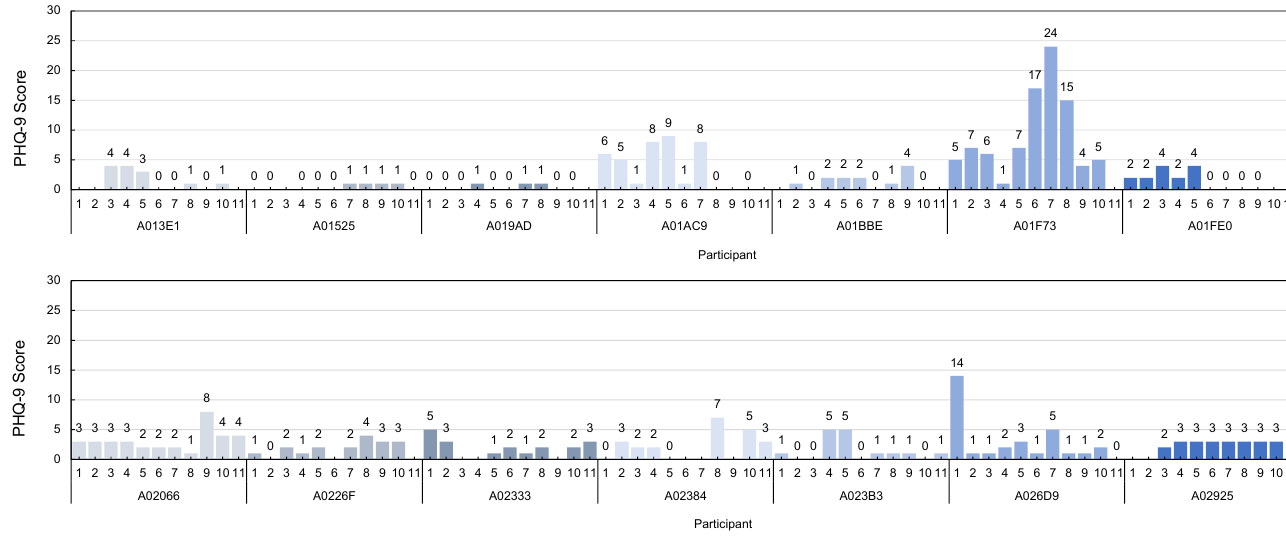
Figure 4. Results of Weekly PHQ-9 Score for All Participants. The PHQ-9 questionnaire is typically classified into five levels of depression. When the total score is within 0 ∼ 4, it is a normal range, indicating a calm state without depression. A score of 5 to 9 indicates that the degree of depression is mild and requires follow-up.